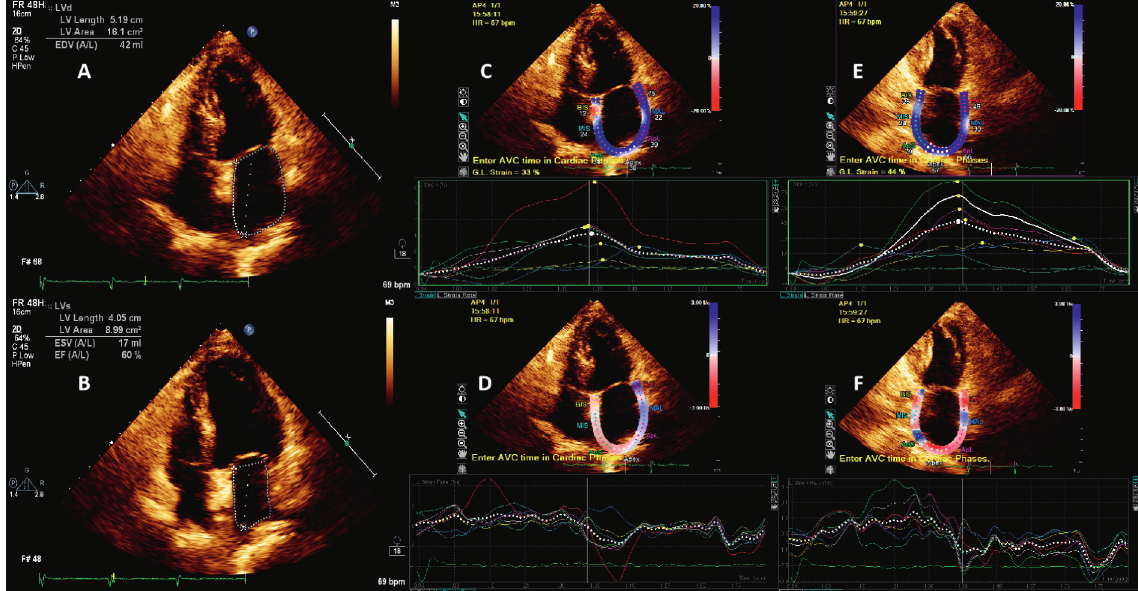
Figure 3: Cardiac function measured by echocardiography and speckle tracking echocardiography. (a, b) Measurement of maximum LA volume and minimum LA volume by the single-plane Simpson’s method through an apical four-chamber view. (c, d) Atrial strain and strain rate measured in an apical four-chamber view. (e, f) Atrial strain and strain rate measured in an apical two-chamber